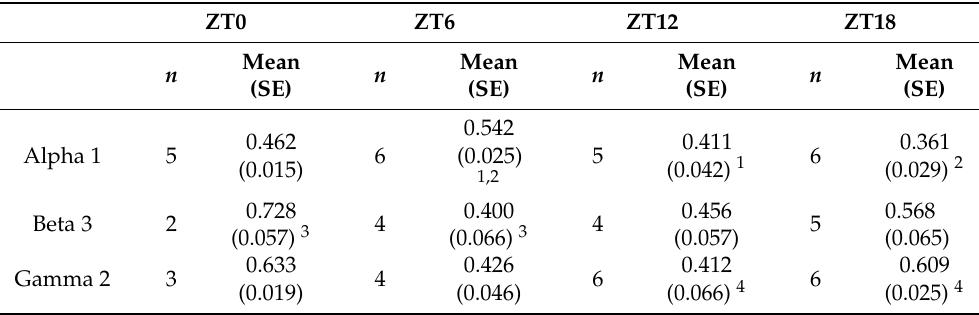
Table 2. Summary statistics of GABA A R subunit expression under LD conditions. Evidence of differences between the different ZTs was tested using ANOVA. Different ZTs that share the same superscript indicate the difference between them is statistically significant (Tukey’s HSD p < 0.05) e.g., 1 denotes a difference between ZT6 and ZT12 for alpha 1.